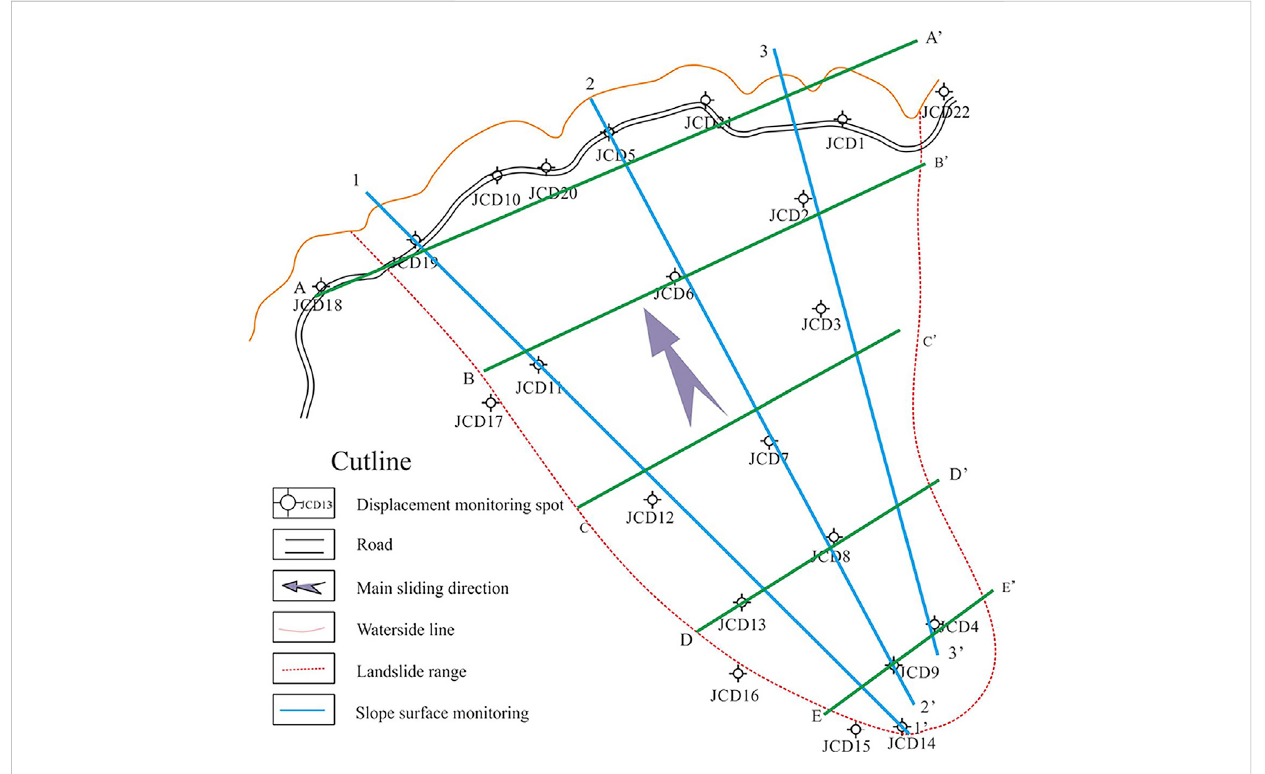
FIGURE 3 Plane layout of surface displacement monitoring.